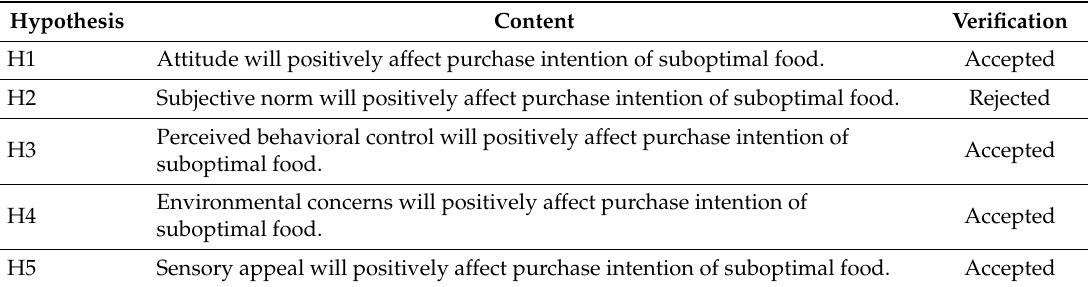
Table 6. Summary of hypothesis